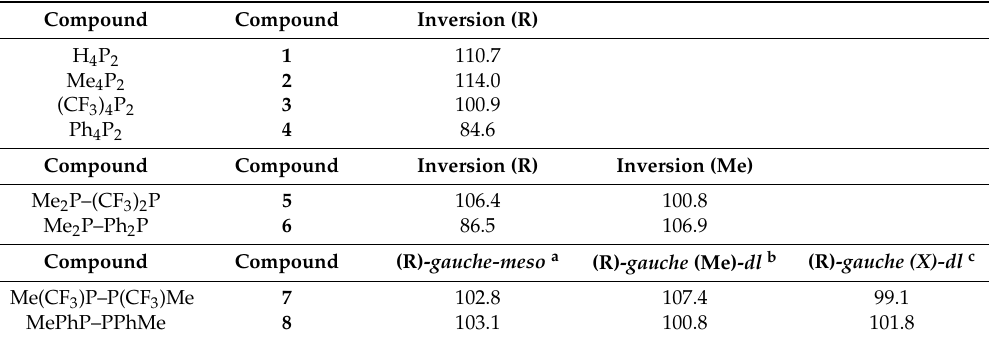
Figure 1. Constraining all three angles at phosphorus to 120 ◦ forces a planar geometry, approximating the transition state for pyramidal inversion at one phosphorus centre. Red arrow indicates the rotation around the P–P bond. Table 4. ∆ G barrier, in kJ·mol − 1 , to pyramidal inversion at one phosphorus centre for 1 – 8 .